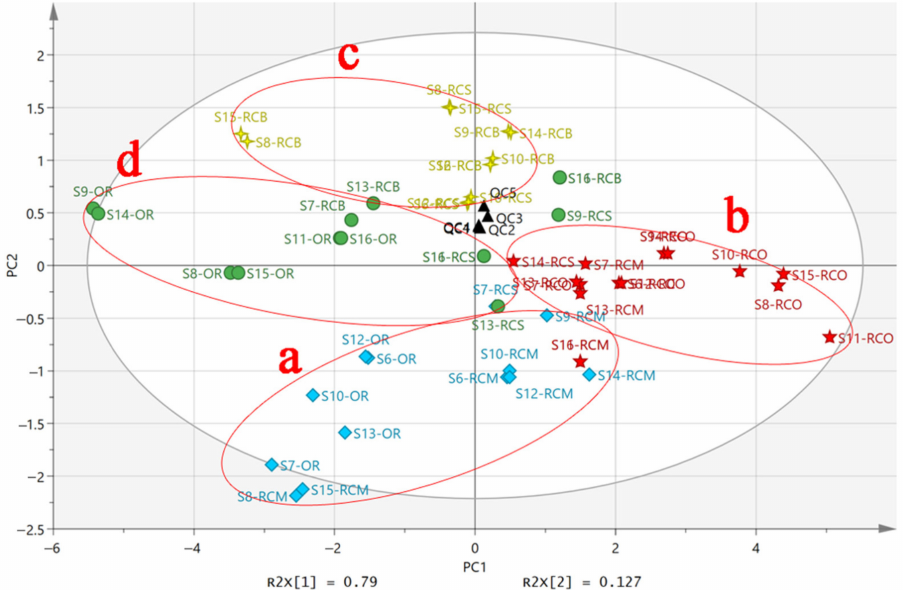
Figure 9. The PCA score plot of six PUFAs in different tissue of Rana chensinensis .